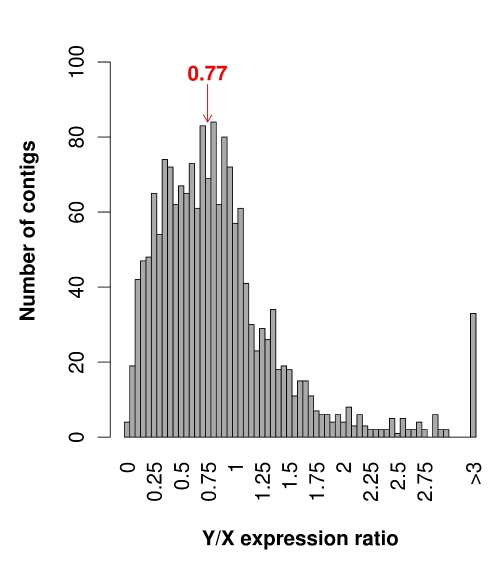
Distribution of Y/X expression ratios in S. latifolia males for the 1,736 sex-linked contigs.Total Y and X read numbers were summed at sex-linked SNP locations for each contig and normalized for each male separately, then averaged across males to obtain the Y/X ratio. The median is shown in red.